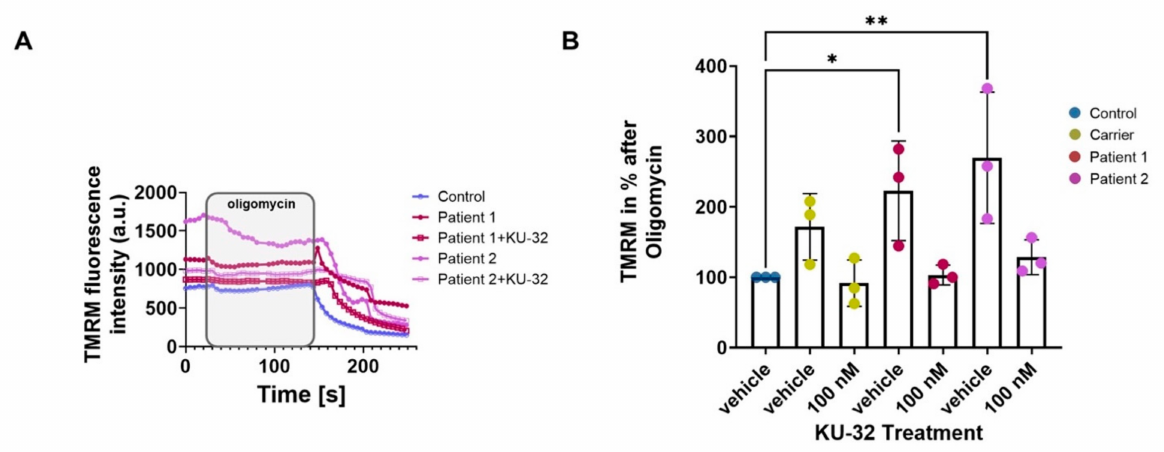
Figure 2. ARSACS patient fibroblasts show a significantly deeper depolarisation after oligomycin administration, which is significantly reduced upon 100 nM KU-32 treatment. Fibroblast lines were cultured for 24 h with either DMSO vehicle or 100 nM KU-32 prior to equilibration with 25 nM TMRM for 45 min and imaging. ( A ) Kinetic curves of the TMRM fluorescence intensity of vehicle-treated control, carrier, and ARSACS Patient 1 and 2 fibroblasts following the addition of oligomycin (2 µ g/mL), rotenone (5 µ M) and FCCP (1 µ M). ( B ) Graph showing the increase in depolarisation after oligomycin administration in percentage normalised to control. * p ≤ 0.05; ** p ≤